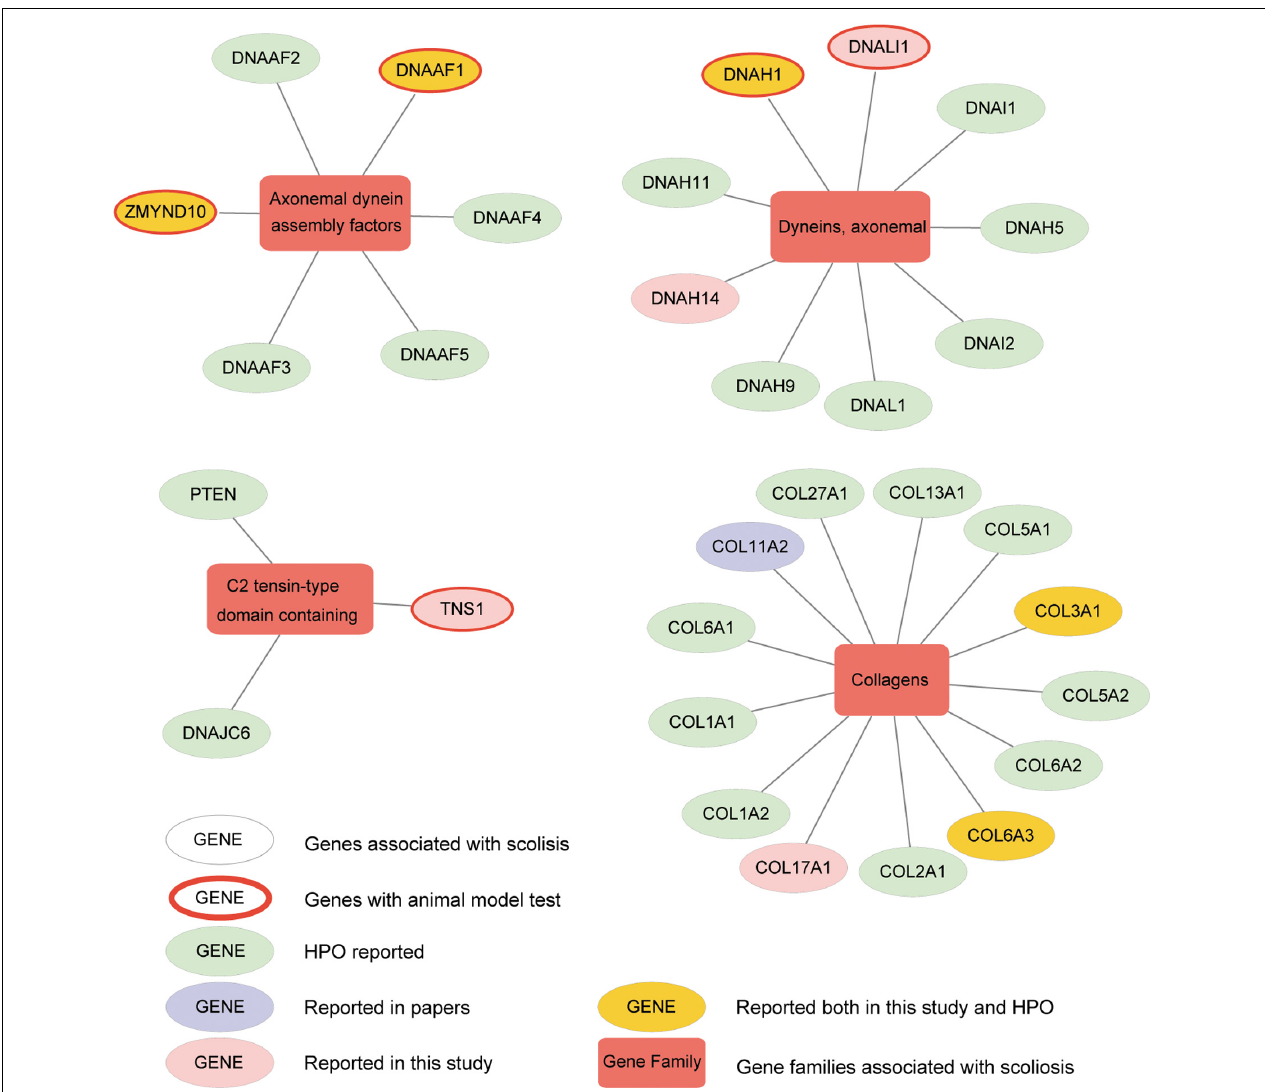
FIGURE 6 | Altered genes and gene families in adolescent idiopathic scoliosis (AIS). The four gene families significantly enriched with mutated genes (Fisher exact test, adjusted P -value < 0.05) are shown. Circle means gene, and box means gene family associated with AIS. Genes with red ring are the ones identified to be associated with scoliosis in zebrafish after knockout. Genes in yellow circle are the ones reported both in our study and HPO (Human Phenotype Ontology). Genes in pink circle are the ones reported in our study. Genes in purple circle are the ones reported in published articles. Genes in light green circle are the ones reported in